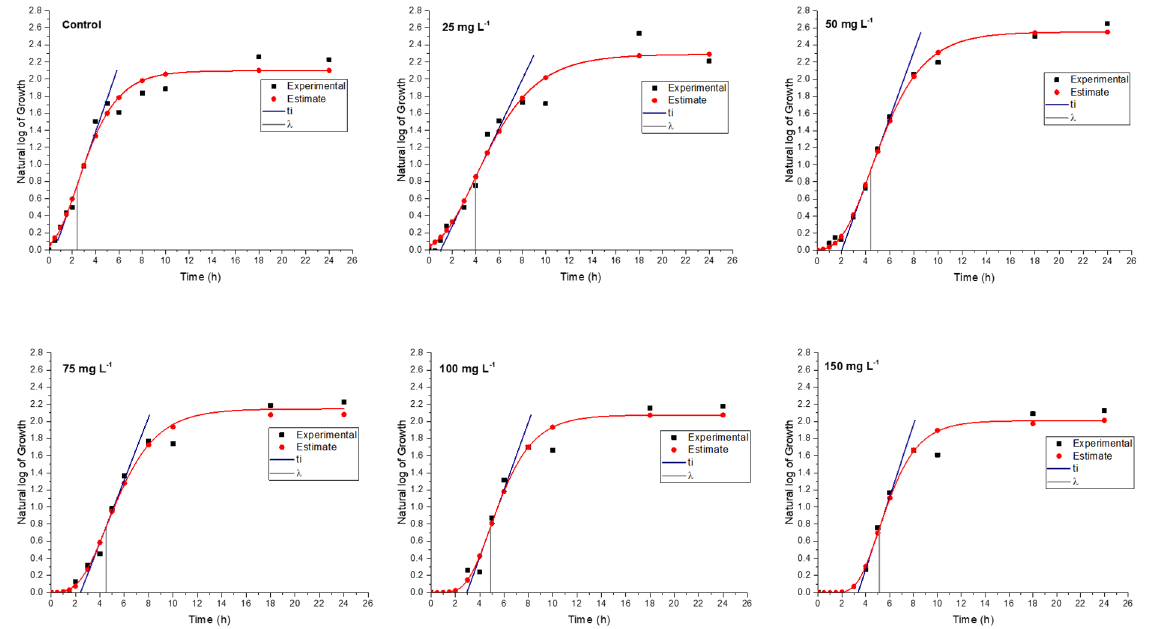
Figure 7. MRSE experimental and predicted growth curve in response to rosin maleic anhydride nanoparticle treatment.